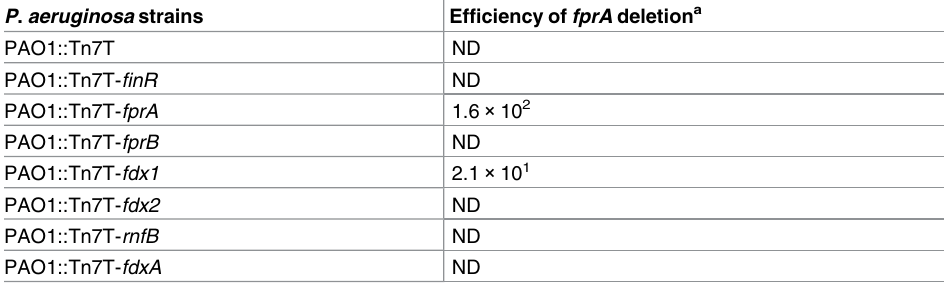
Table 1. Efficiency of fprA deletion in P . aeruginosa strains carrying an extra copy of various genes. P . aeruginosa